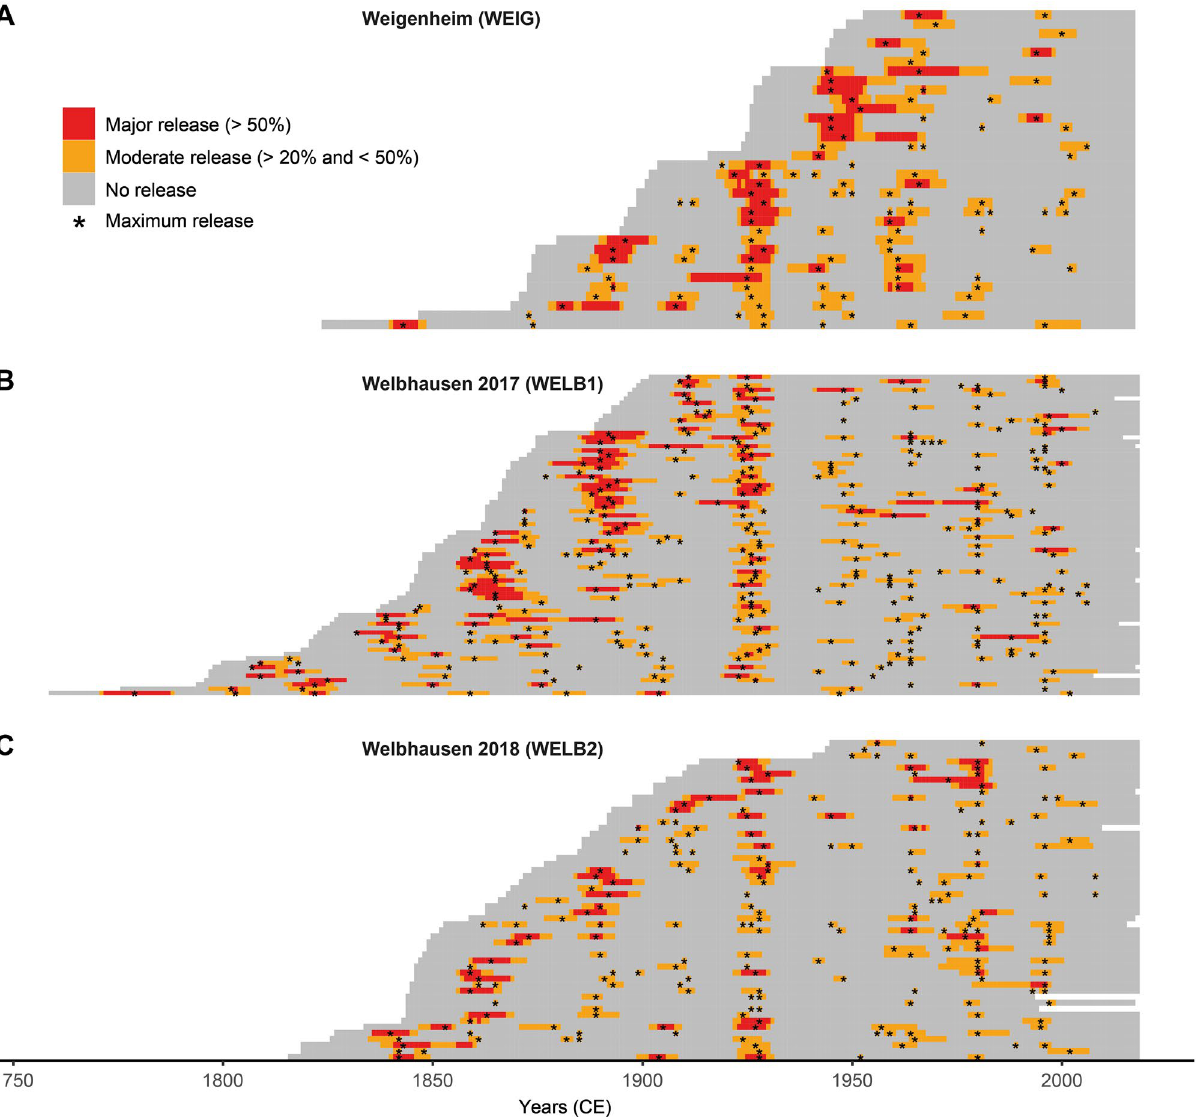
Figure 3. Bar graphs with release events for every tree from Weigenheim ( A ) and Welbhausen ( B , C ). Major release events are shown in red, moderate release events in orange. Release maxima for longer release episodes are highlighted (black stars). This figure was created using R software (https ://www.r-proje